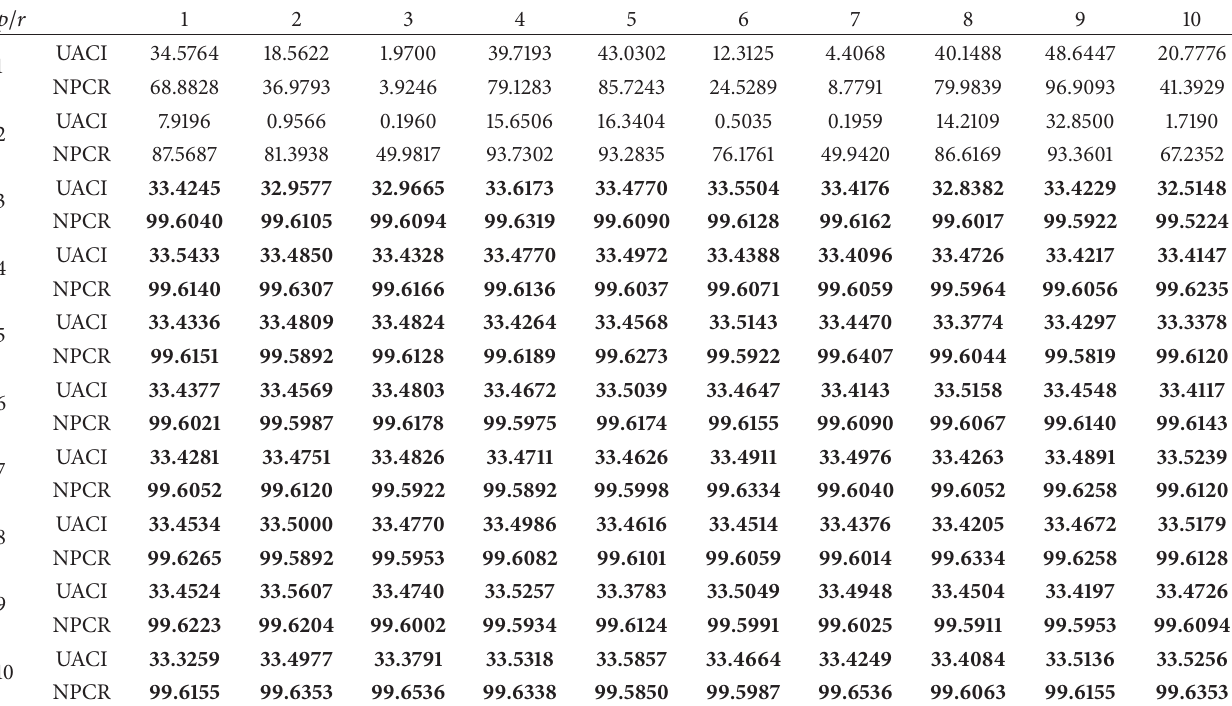
Table 11: Calculated UACI and NPCR for different combinations of 𝑝 and 𝑟 while 𝑞 = 1 in